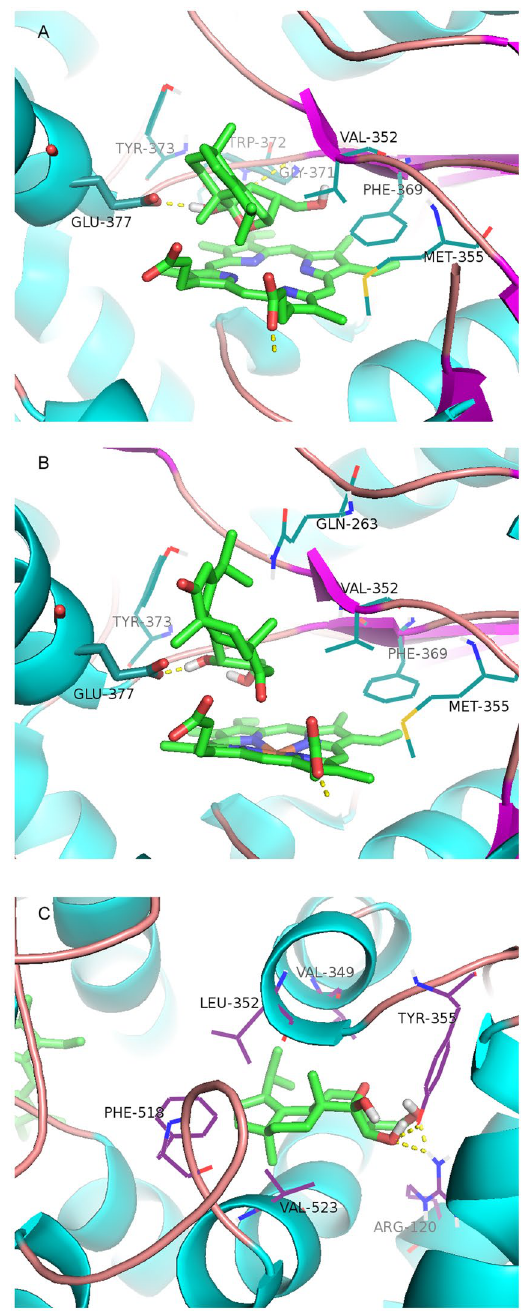
Figure 8. Molecular docking simulations of the binding of compounds 11 and 14 to iNOS and COX-2. Virtual drug-protein complexes including compounds 11 ( A ) and 14 ( B ) for iNOS, and 11 ( C ) for COX-2 were obtained at lowest energy conformation, while potential hydrogen contacts between compounds and proteins were highlighted by dashed lines. Atoms were colored as follows: carbon, cyan; nitrogen, blue; oxygen, red; hydrogen, gray; sulfur,